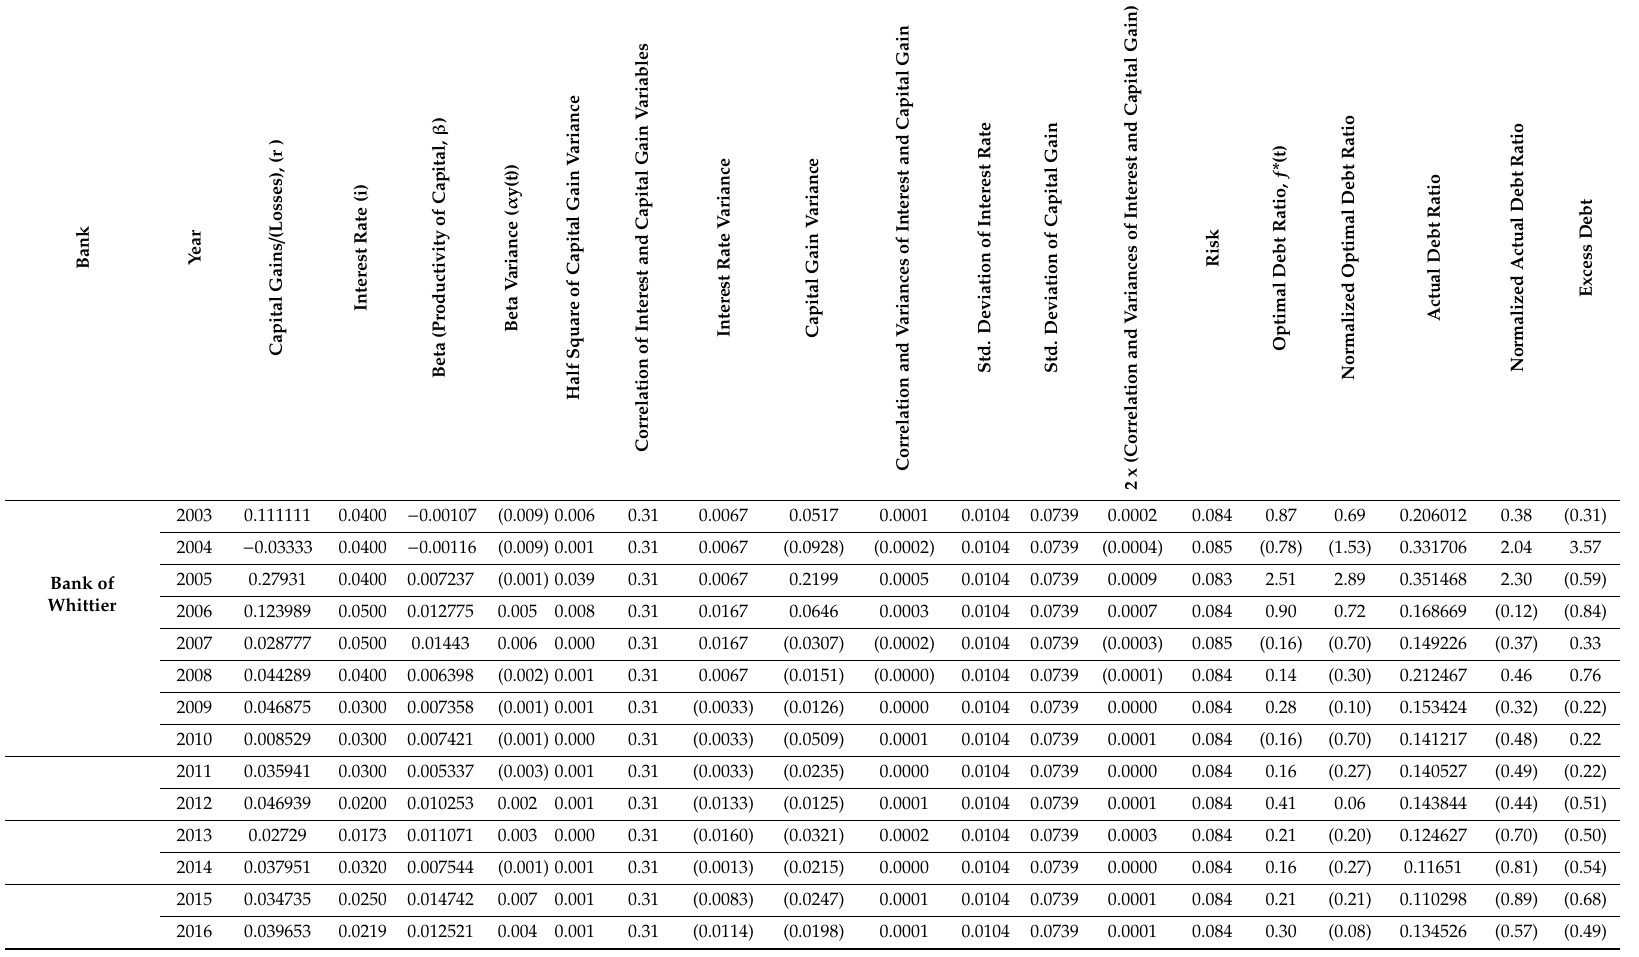
Table A16. Calculations of Optimal and Excess Debt: Bank of